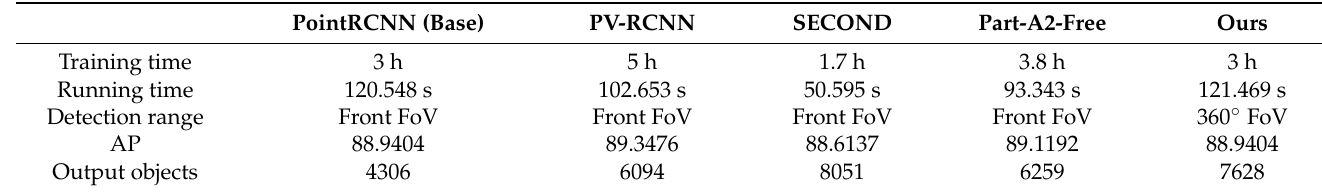
Figure 11. Sensors and detection results of different the methods: ( a ) Roadside LiDAR; ( b ) PointRCNN (base); ( c ) PV-RCNN; ( d ) SECOND; ( e ) Part-A2-Free; ( f ) The proposed method. Table 5. The Performance of different detection